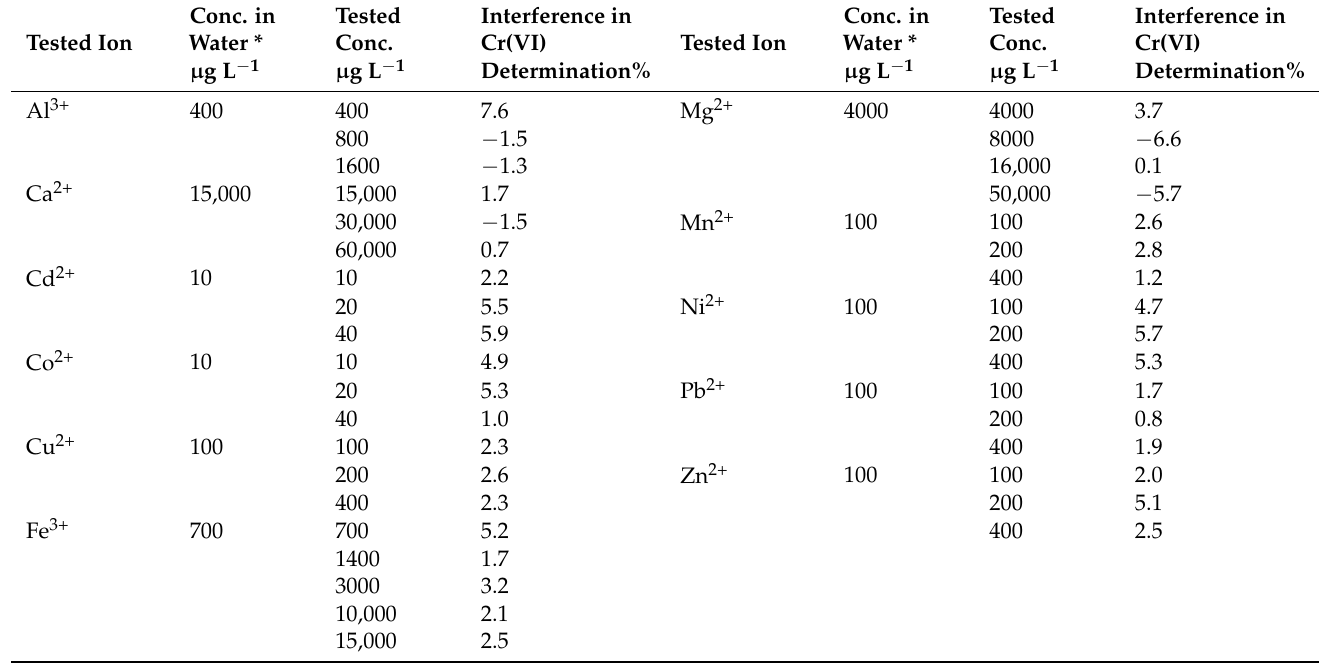
* Highest expected ions concentrations in streams and/or groundwaters